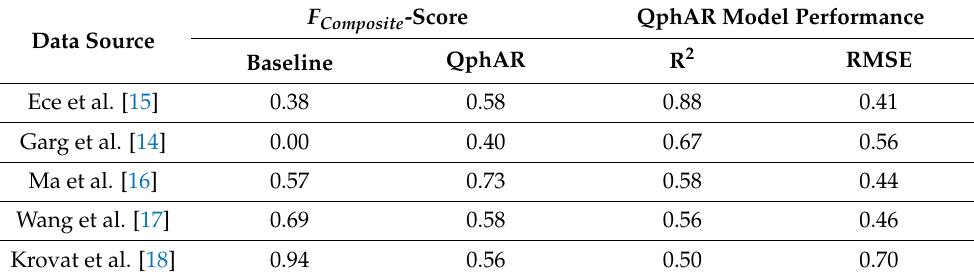
Table 1. Test performance of the shared pharmacophore baseline models and refined pharmacophores obtained from the corresponding QPhAR